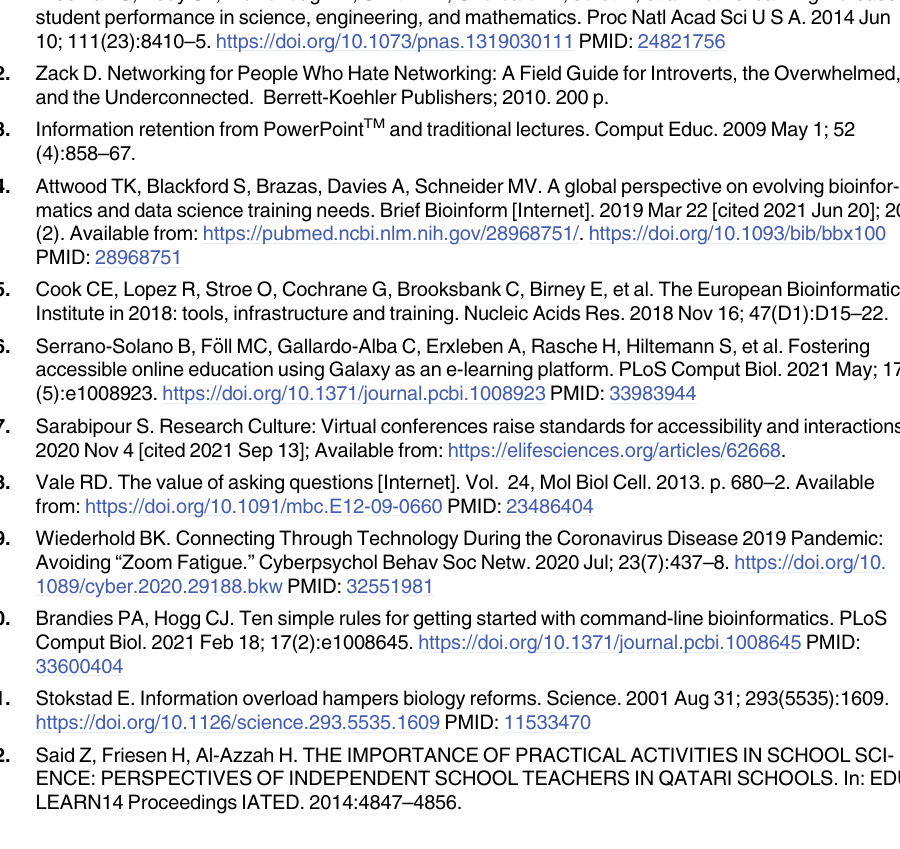
S1 Table. Summary of the 10 rules for using virtual interaction to build higher-level learn- ing into bioinformatics short